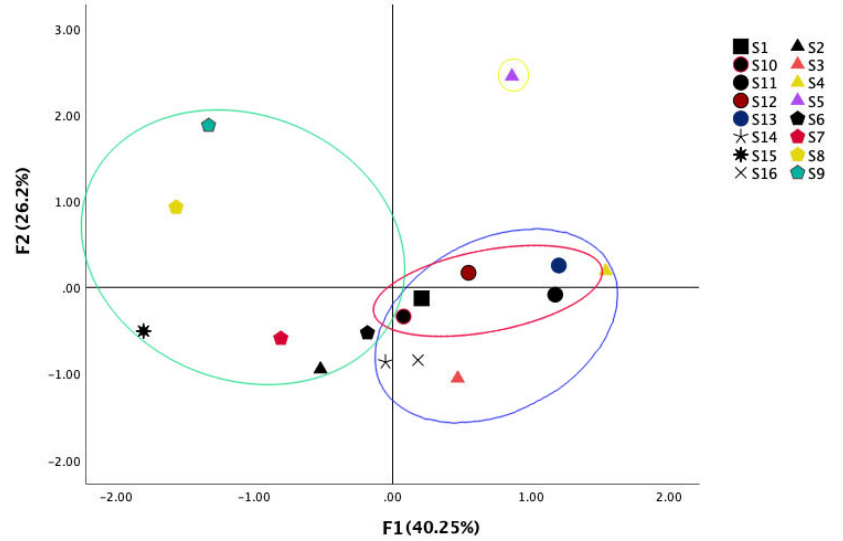
Figure 7. The 2D score plot of all active ingredients of 16 batches of different processing methods of S. miltiorrhiza with the first two three principal components.